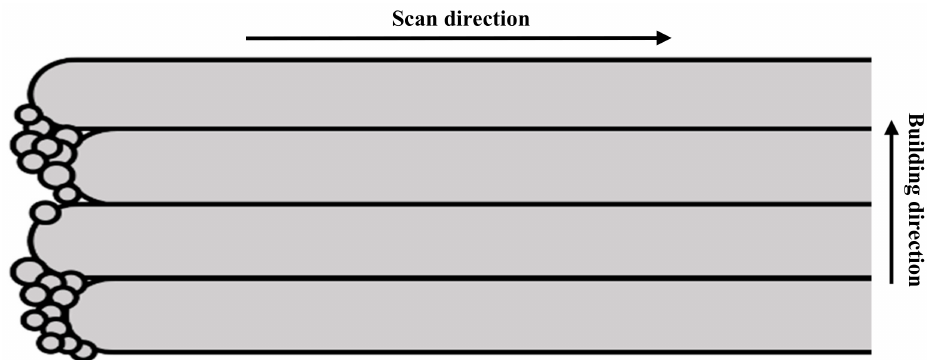
Figure 8. Effect of scan direction on roughness.